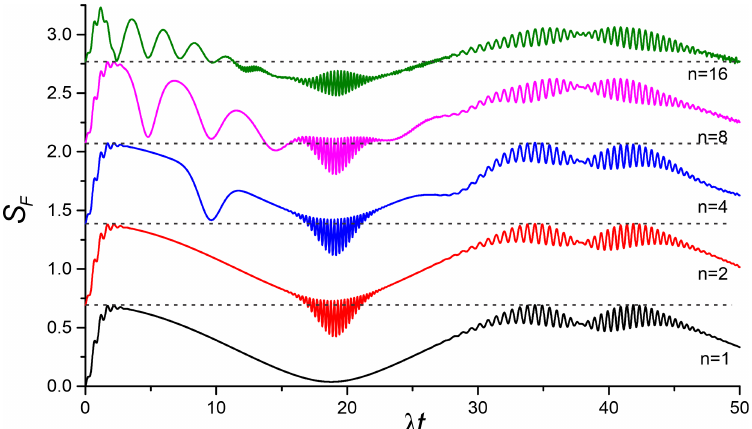
Figure 1. The evolution of the field entropy of Kaleidoscope-States as a function of the scaled time λ t and different values of statistical mixture of coherent states n = 1,2,4,8 and 16, with α = 6.0. Their initial values are calculated as ln ( n ) and are indicated in the figure by dotted